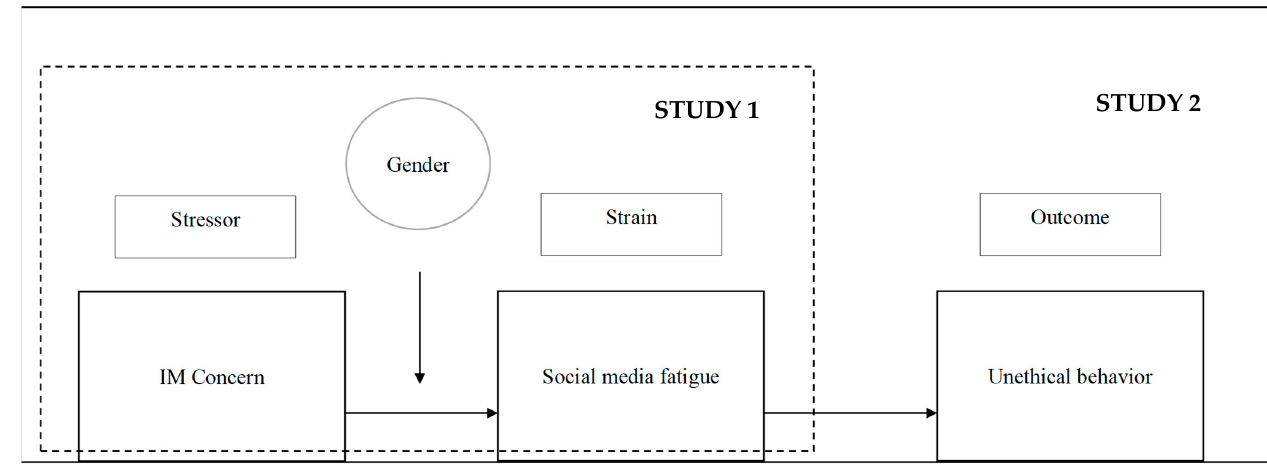
Figure 1. Research